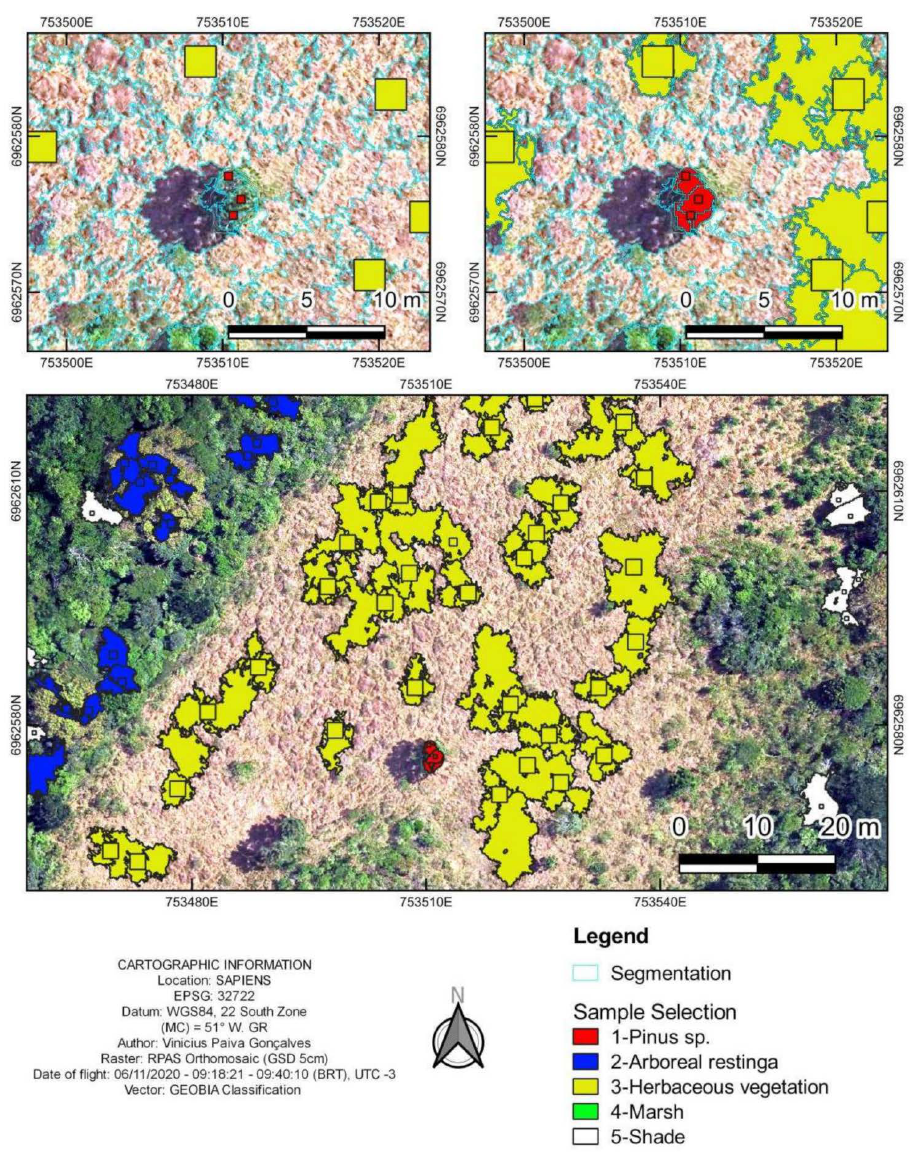
Figure 4. Example of selected segments by location in the Sapiens Park area. CRS: EPSG 32722. Horizontal datum WGS84, UTM projection system, 22 South Zone. MC 51 ◦ W. GR. Raster: RPAS Orthomosaic (GSD 5 cm). Flight date: 06/11/2020, 09:18:21–09:40:10 Brasilia Time (BRT),